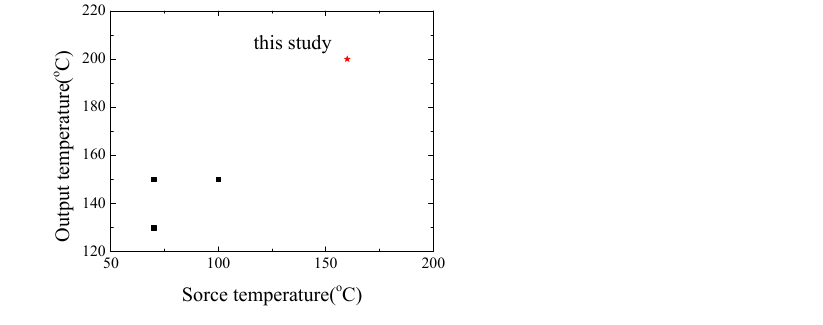
Figure 1. High heating temperature of current heat pumps in the literature [6–8].